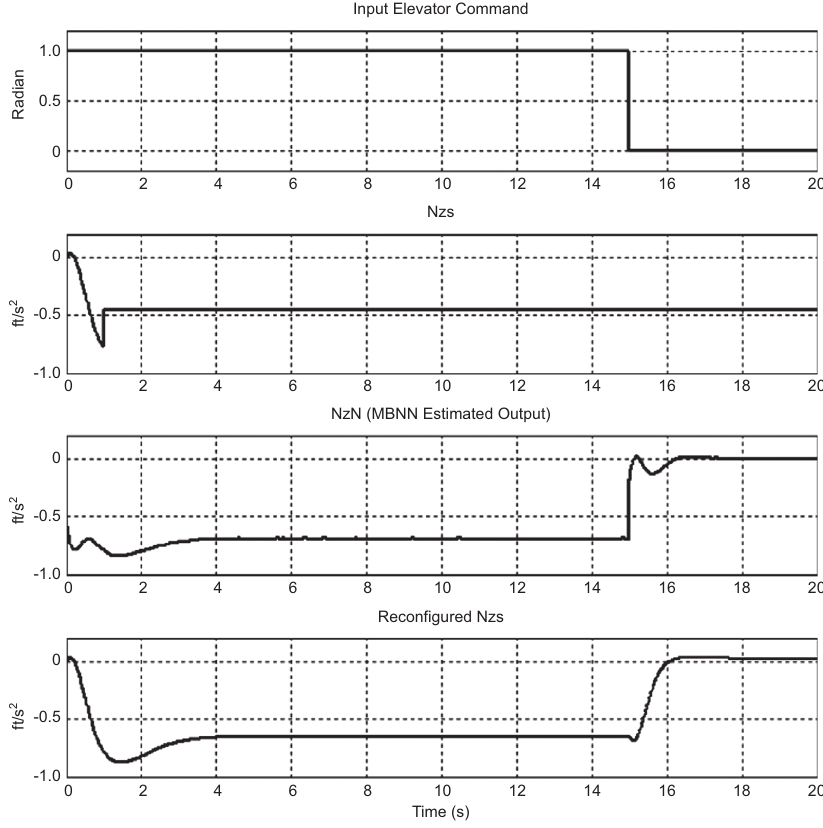
Figure 12. SFDA for Stuck Sensor Fault of “–0.45” at 1 s (Transient State